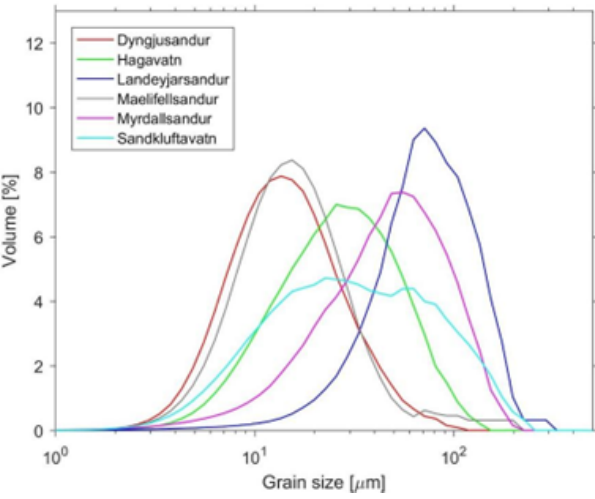
Figure 9. Grain size distributions of samples from Icelandic source areas (redrawn from Varga et al.,